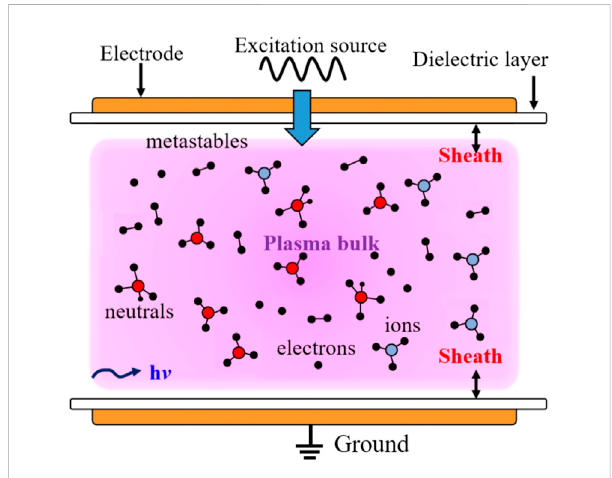
FIGURE 1 Model sketch of dynamics and energy transport processes in a DBD